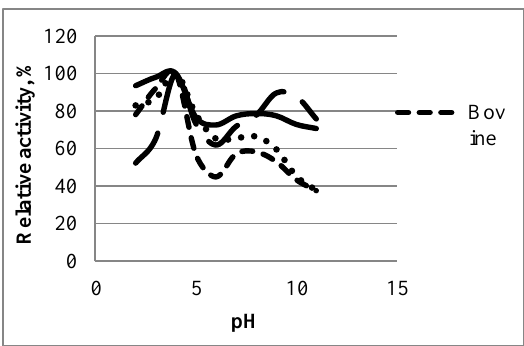
Figure 2. pH influence the enzyme